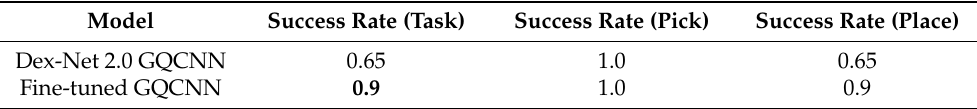
Table 1. Evaluation of our fine-tuned GQCNN against the Dex-Net 2.0 pre-trained GQCNN for depth images generated from a camera with the same extrinsic parameters as in the training setup. Model